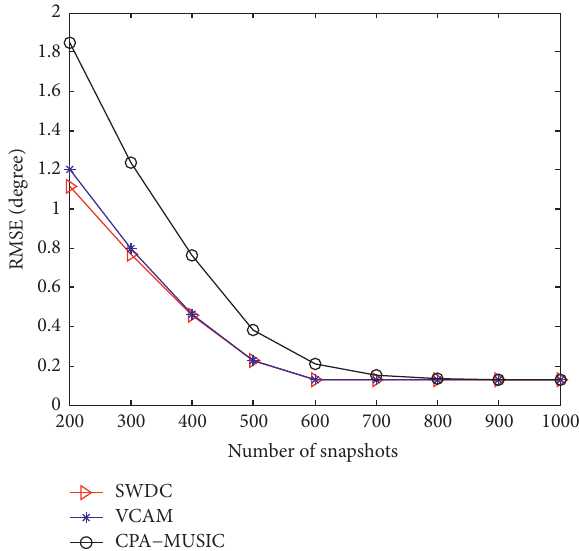
Figure 6: RMSE versus the number of snapshots with SNR being